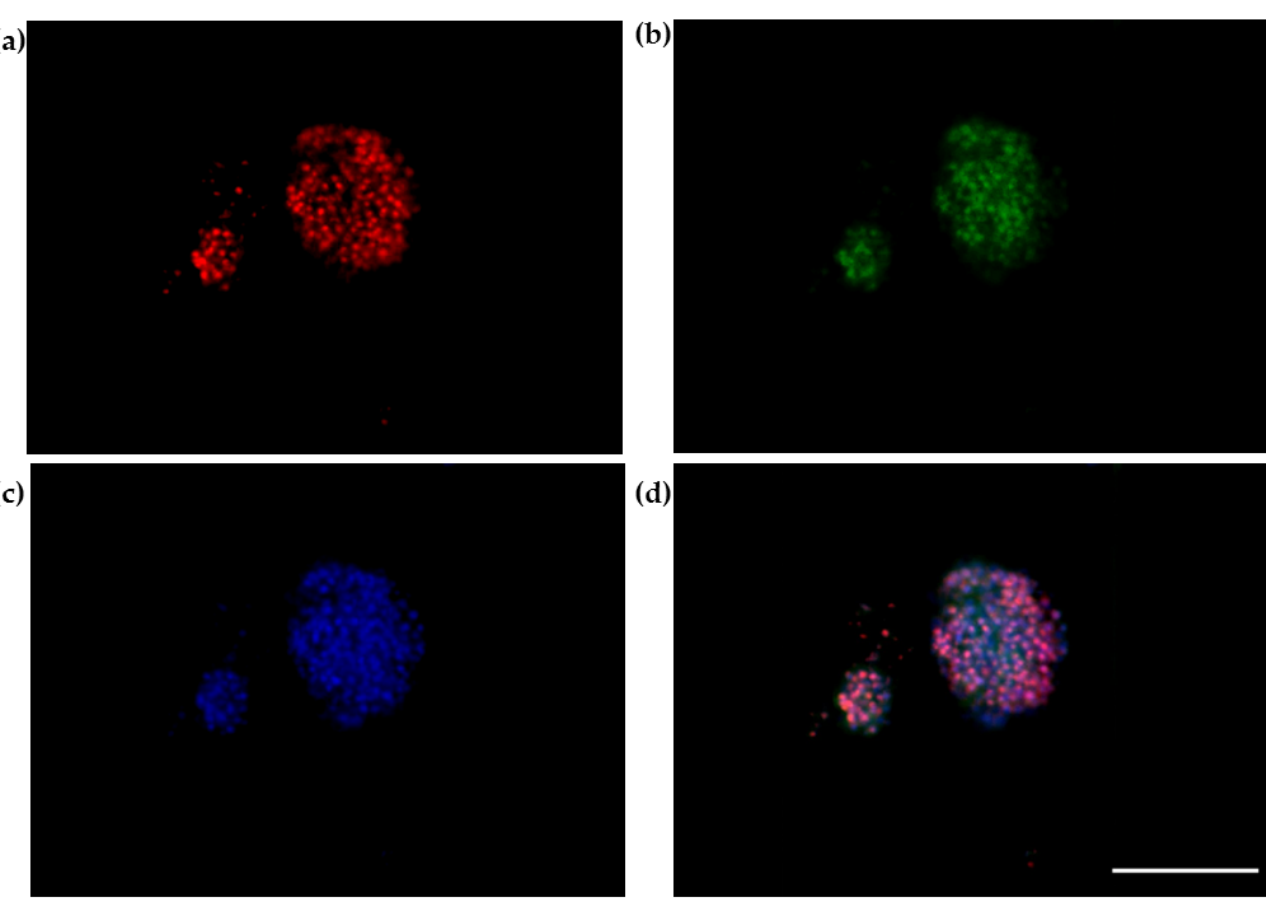
Figure 8. Annexin/PI on neural spheroids without 1.5mM MPP + . The number of apoptotic cells is higher compared to necrotic cells. The graph shows the means ± SEM of three experiments. Statisti- cal analysis was performed through the analysis of variance (ANOVA) and the Dunnet’s post-test. The differences were considered significantly between apoptotic and necrotic cells. **** p < 0.01.